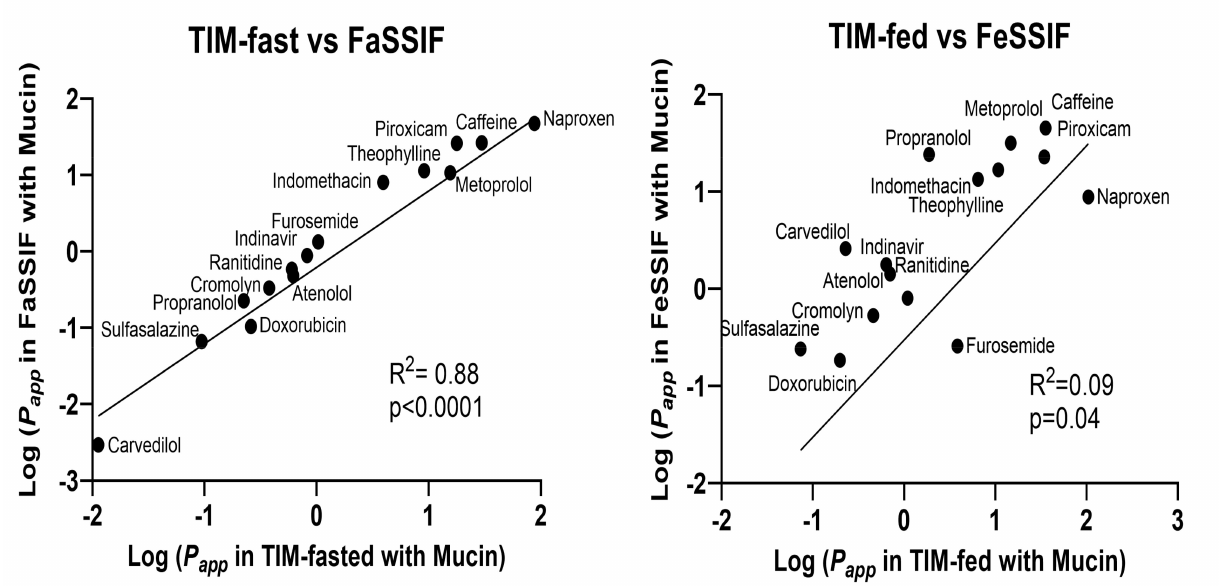
Figure 5. The linear correlations based on Caco-2 P app values obtained in TIM-fasted and FaSSIF media or TIM-fed and FeSSIF